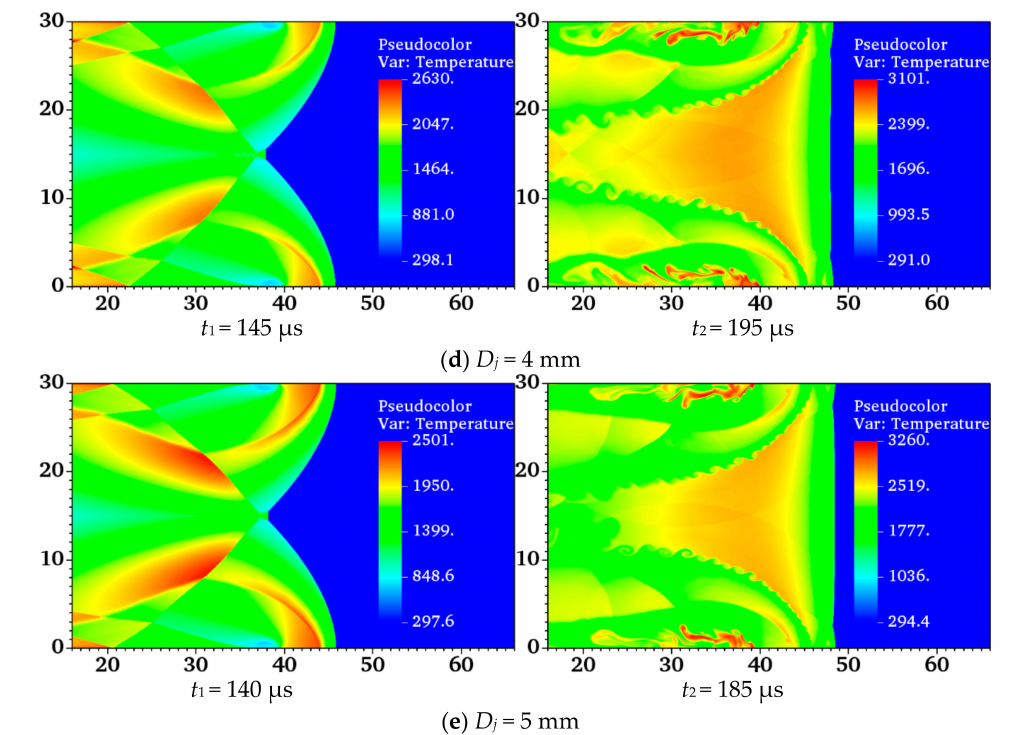
Figure 11. Contours of temperature for successful detonation initiation.